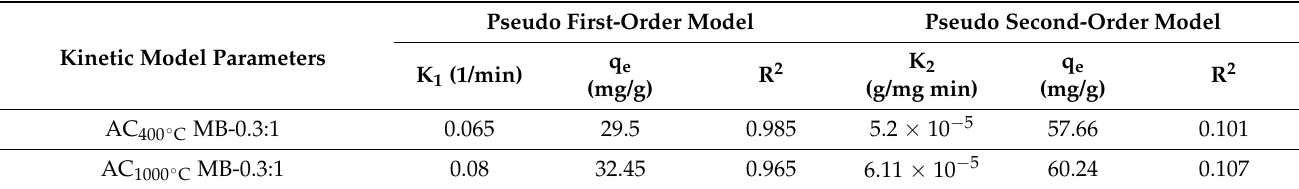
Table 3. Kinetic model